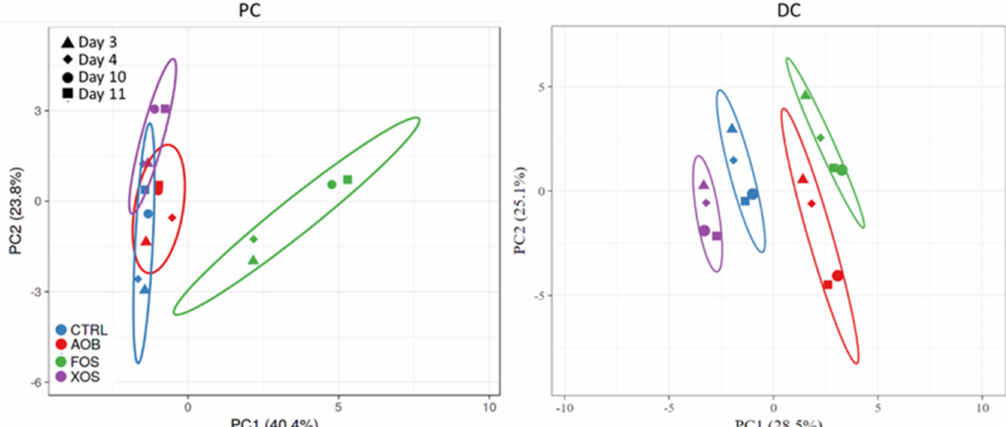
Figure 5. Principle component analysis plots for ( left ) PC and ( right ) DC long-term SHIME samples of donor 2, representing microbial community composition (significantly affected OTUs) obtained on four different time points (days 3/4/10/11 of treatment) for blank control, AOB, XOS and FOS. Ellipses indicate a confidence interval of 95%. PC = proximal colon; DC = distal colon; AOB = antioxidant blend; XOS = xylooligosaccharides; FOS =